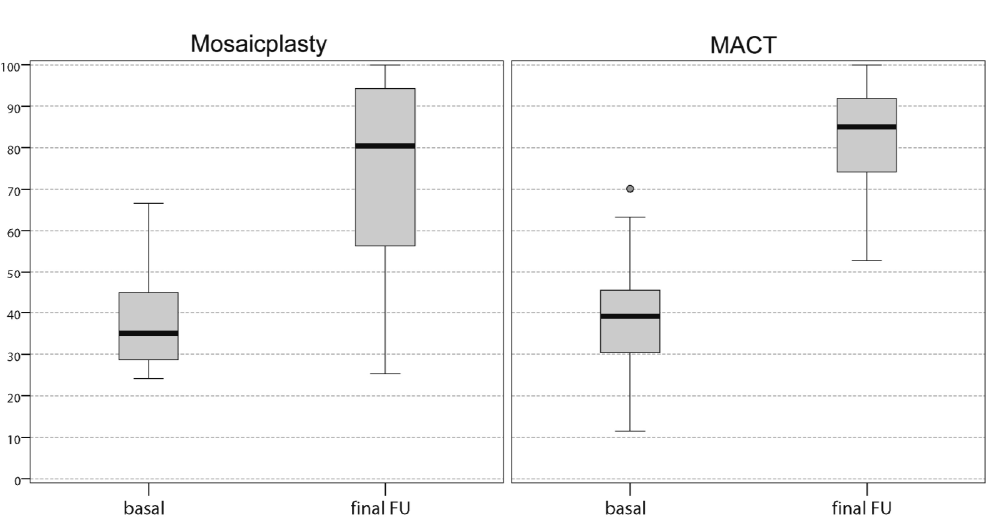
Figure 1. Comparison of the International Knee Documentation Committee (IKDC) subjective score achieved at a final follow-up of 12 years by both groups of patients. The values are expressed in median and 25th and 75th percentiles. No significant differences were found between the two groups. FU, follow-up.